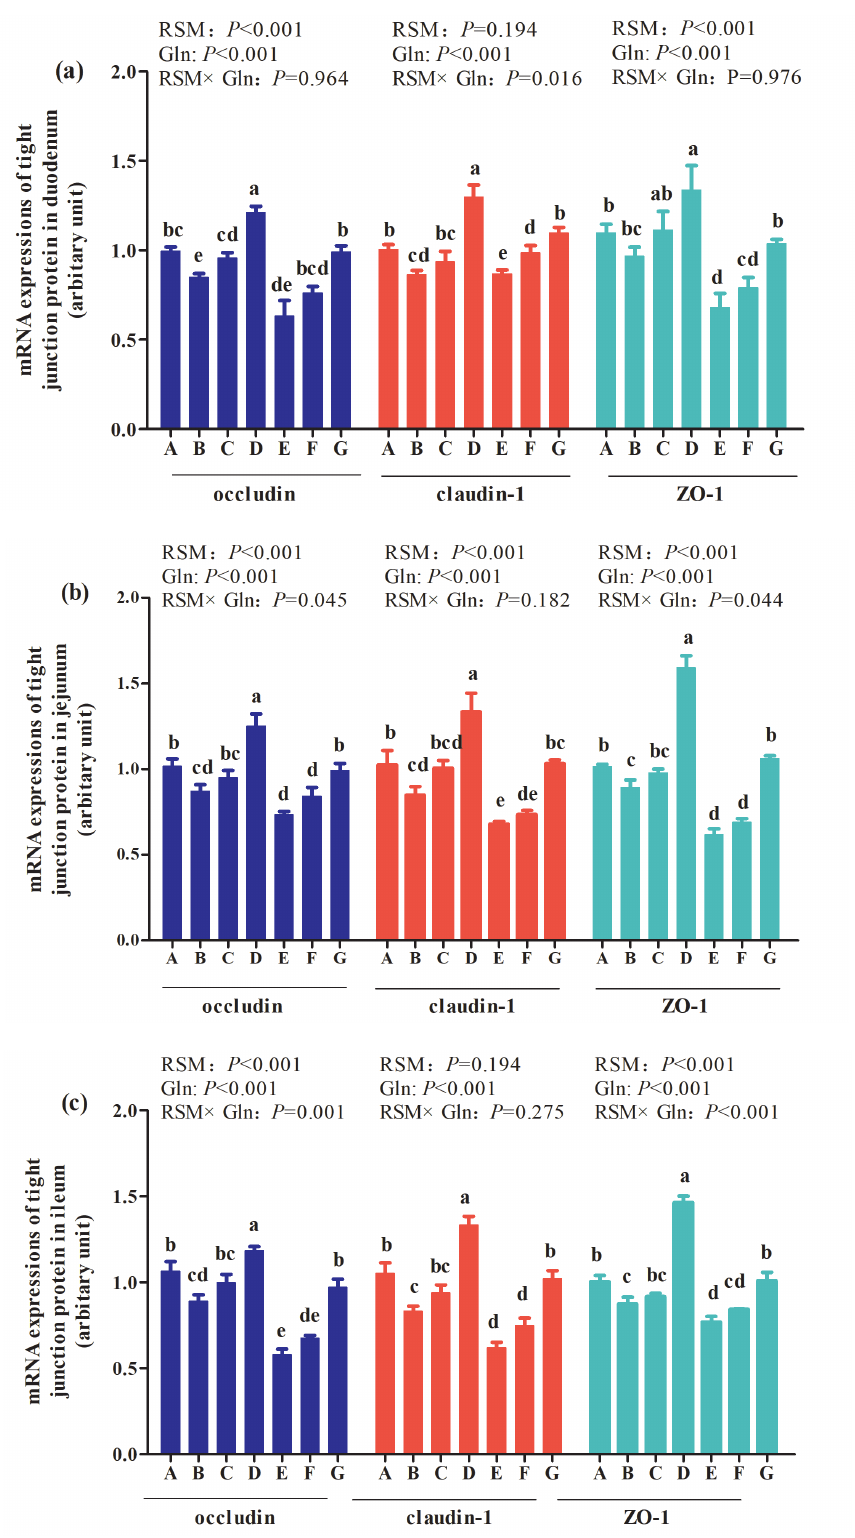
Figure 3. Effects of different levels of rapeseed meal substitution and glutamine on mRNA expression of intestinal tight junction protein of Qian- dongnan Xiaoxiang Chicken at 21 days of age (n = 10 per treatment group). Columns in the same color with different small letters superscripts mean significant differences (p<0.05). Broilers in the control group (A) were fed with basal diet. Broilers in 10% (B) and 20% RSM (E) were fed with diet containing 10% or 20% RSM, respectively. 10% RSM+0.5% Gln (C), 10% RSM+1.0% Gln (D), 20% RSM+0.5% Gln (F), and 20% RSM+1.0% Gln (G) mean that 0.5% Gln or 1% Gln was separately supplemented based on 10% and 20% RSM